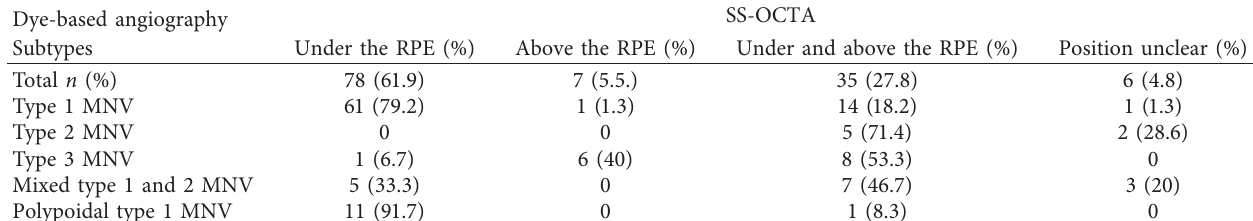
Table 3: Topography in SS-OCTA compared to MNV subtypes as classified by dye-based angiography. Dye-based